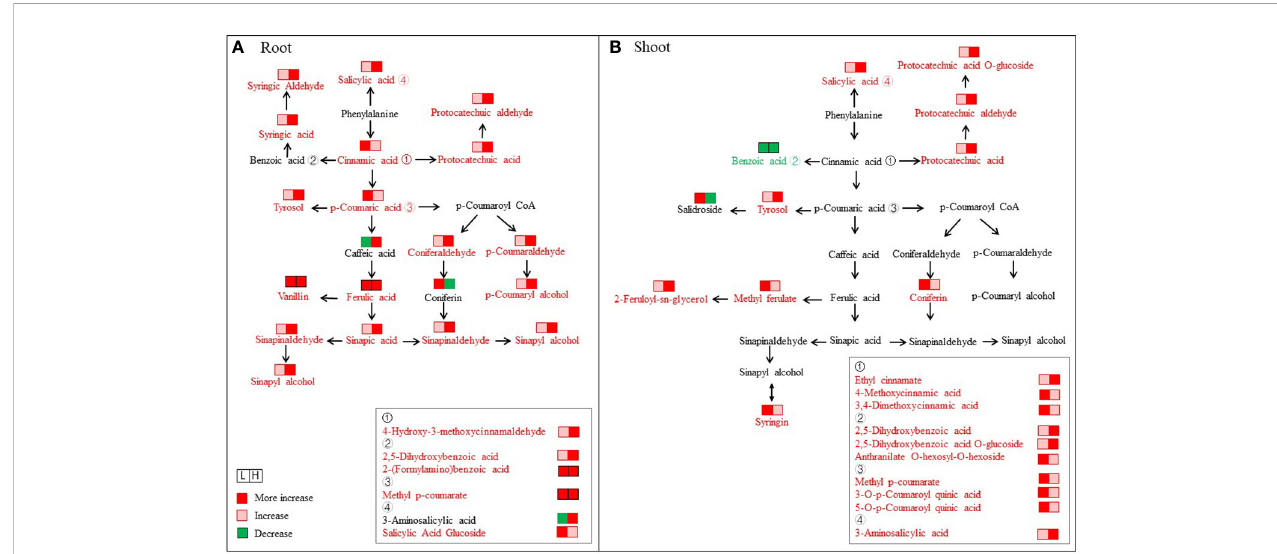
FIGURE 7 Changes in metabolites mapped to the metabolic pathway of phenylpropanoid biosynthesis. (A) Root. (B) Shoot. The metabolites shown in red color indicate increases under both L (50 mM NaCl) and H (300 mM NaCl) conditions compared with CK (0 mM NaCl), while the metabolites with a green color indicate a decrease under both L and H conditions compared with